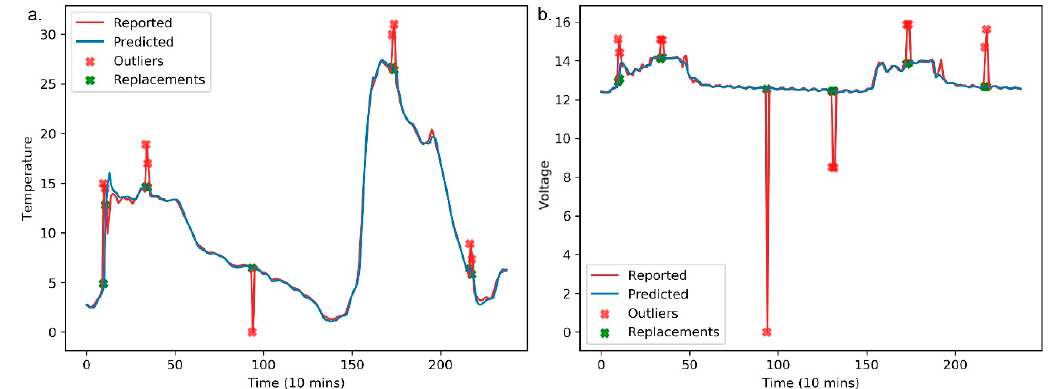
Figure 9. The performance of anomaly detection on panel temperature and operating voltage using